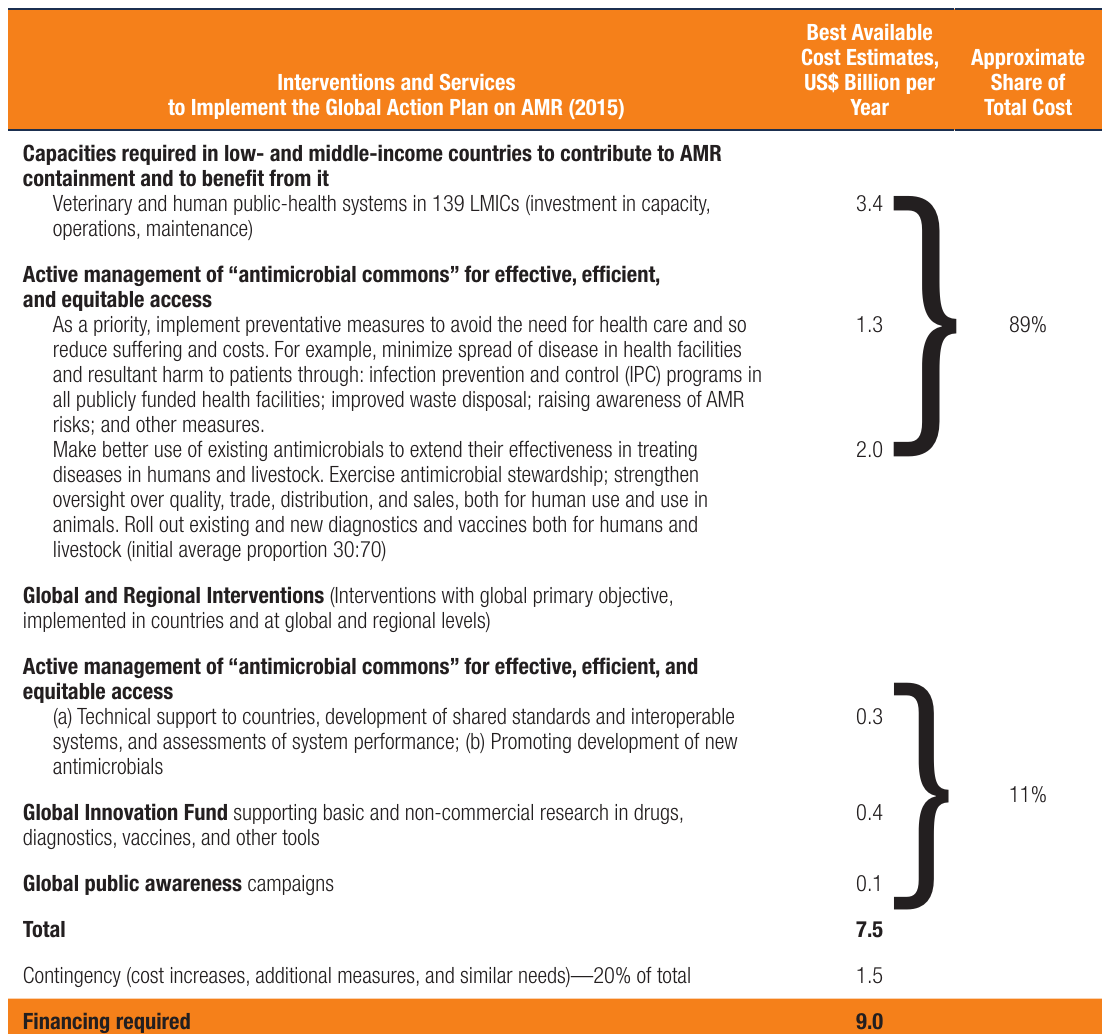
TABLE 1. Cost of Measures to Minimize and Contain AMR